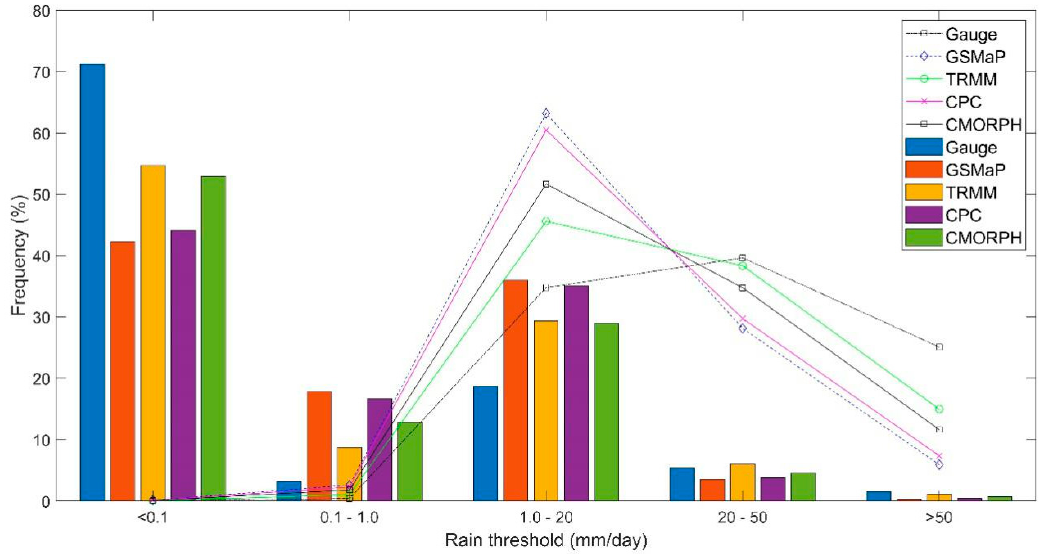
Figure 5. The occurrence frequencies (bars) of CPC, TRMM 3B42, GSMaP, CMORPH, and the daily gauge observations, as well as their relative contributions (lines) to the total rainfall during the period